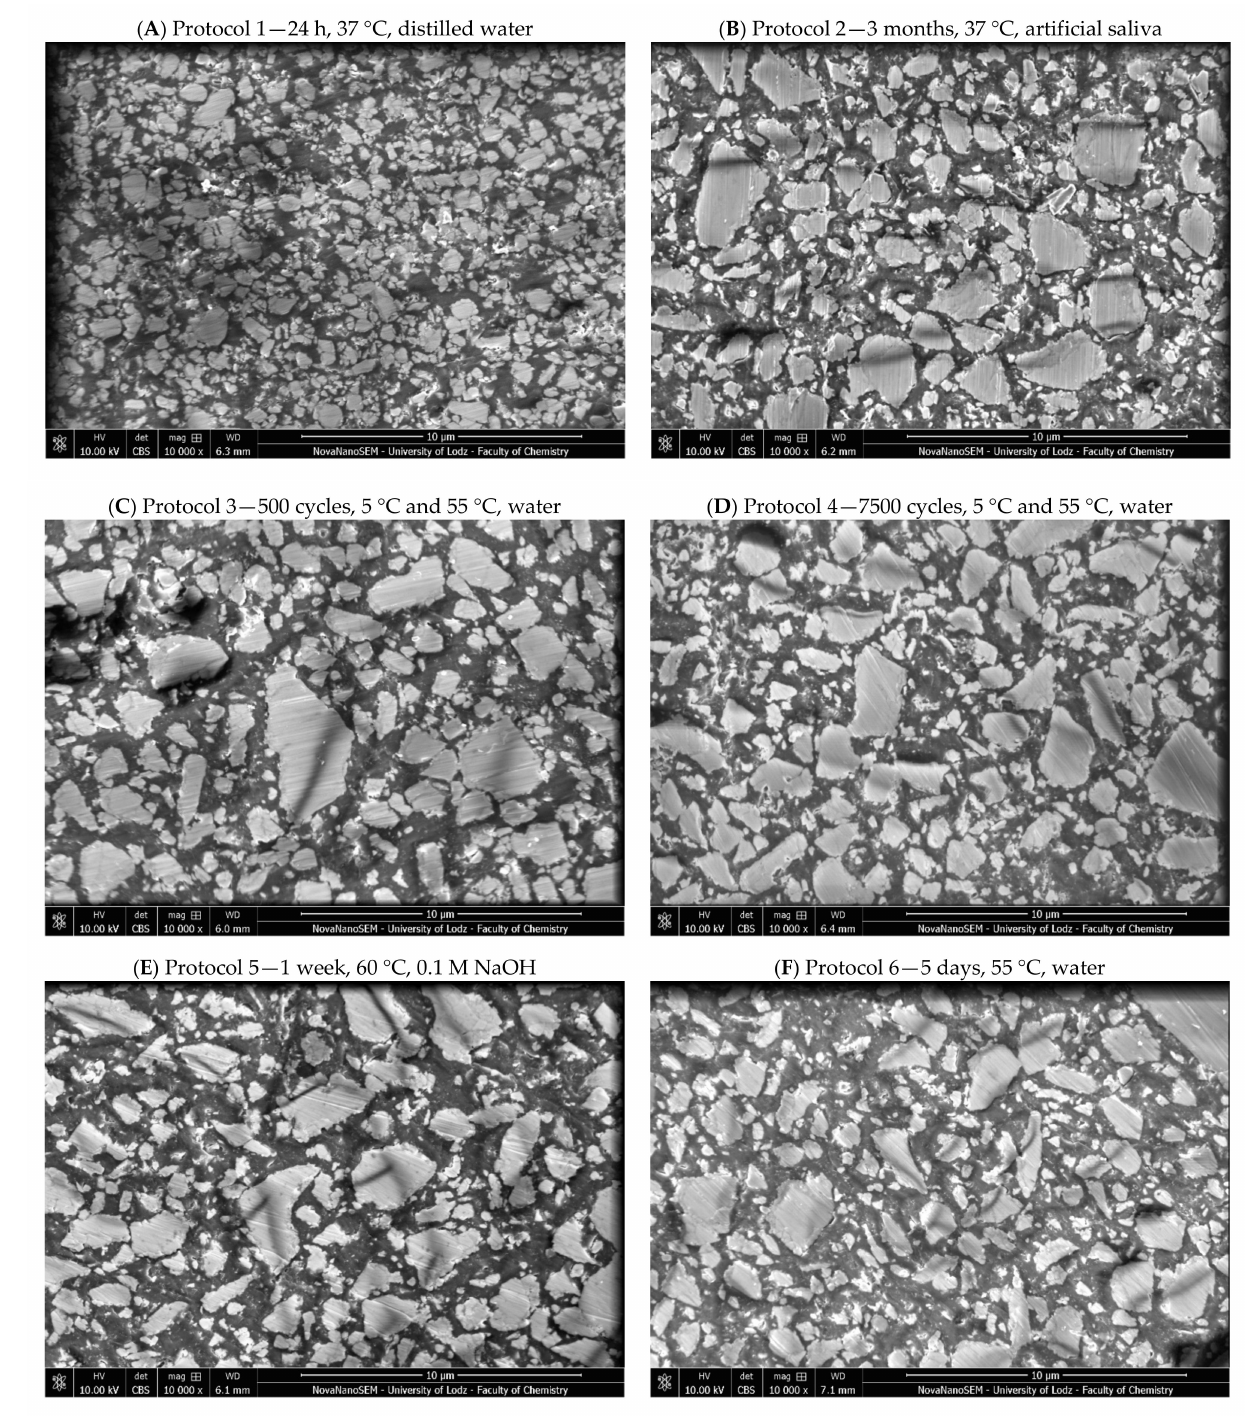
Figure A11. Scanning electron microscopy (SEM) micrograph of Flow-Art at 10,000 × magnification after six aging protocols: ( A ) Protocol 1—24 h, 37 ◦ C, distilled water, ( B ) Protocol 2—3 months, 37 ◦ C, artificial saliva, ( C ) Protocol 3—500 cycles, 5 ◦ C and 55 ◦ C, water, ( D ) Protocol 4—7500 cycles, 5 ◦ C and 55 ◦ C, water, ( E ) Protocol 5—1 week, 60 ◦ C, 0.1 M NaOH, ( F ) Protocol 6—5 days, 55 ◦ C,